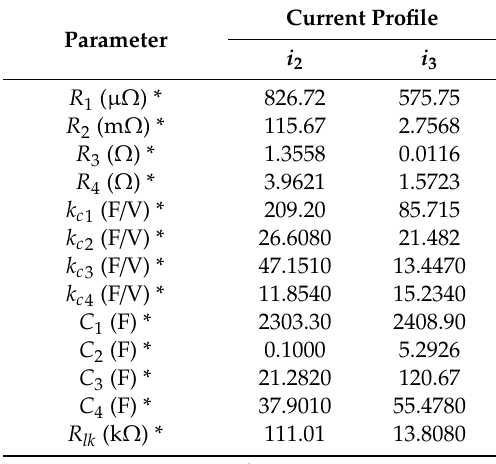
Table A7. Transmission Line Model Parameters.